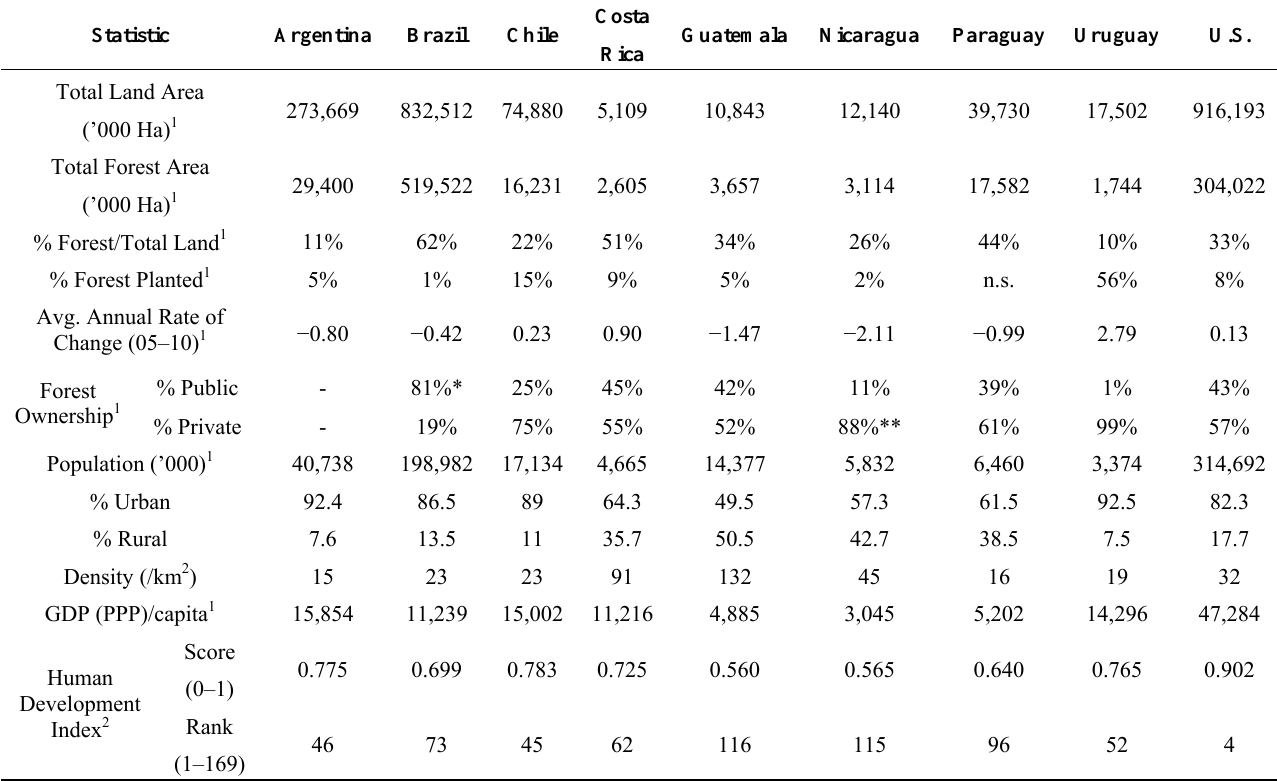
Table 2. Land, forest, and socioeconomic statistics by